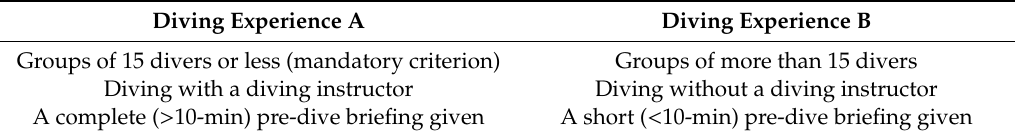
Table 1. Comparison of diving experiences. Diving experience A complied with at least 2 of the 3